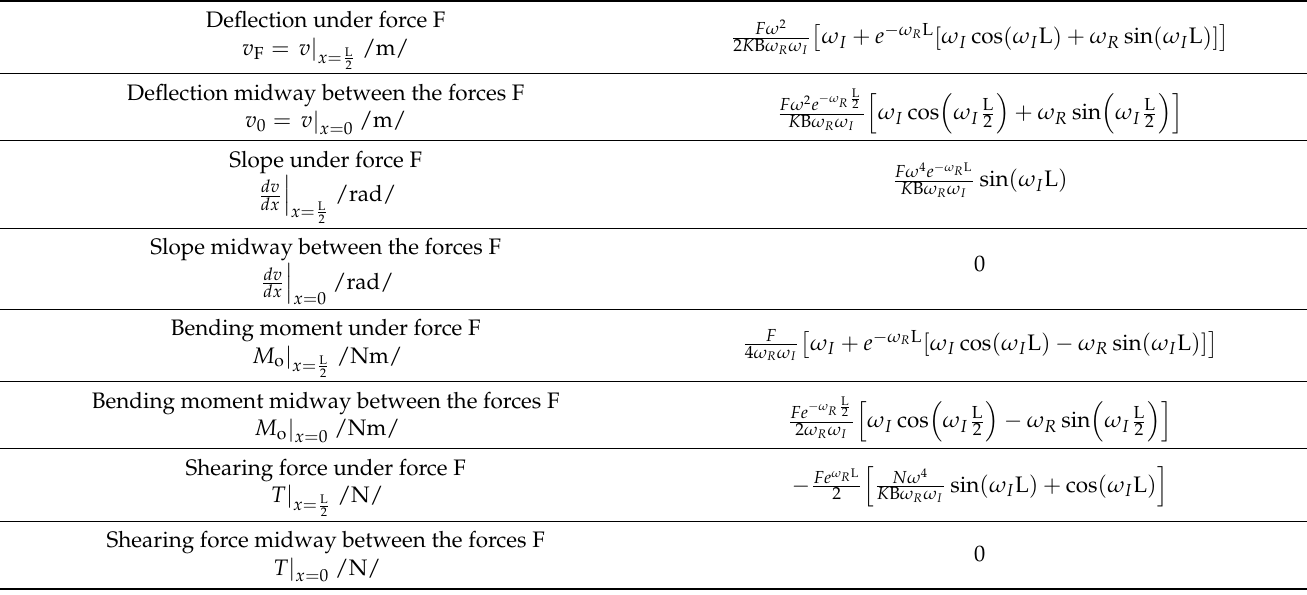
Table 3. Calculation of quantities at the measuring points, i.e., under the force F and midway between the forces F according to Figure